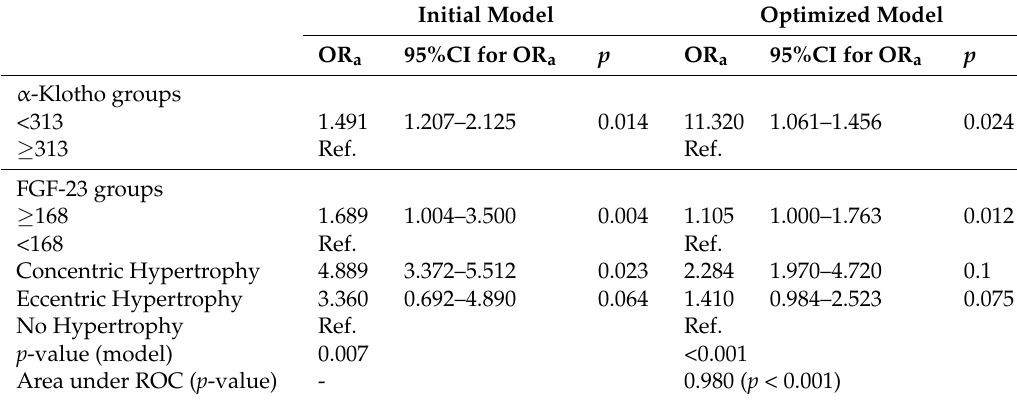
Table 5. Predictive factors of cardiovascular hospitalization.